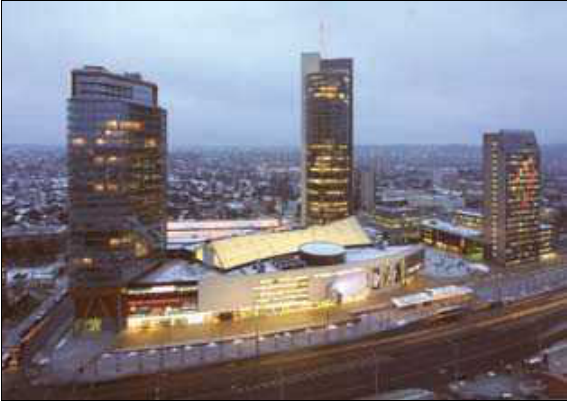
Fig. 17. Mu­ltifu­nction complex in new centr­e of